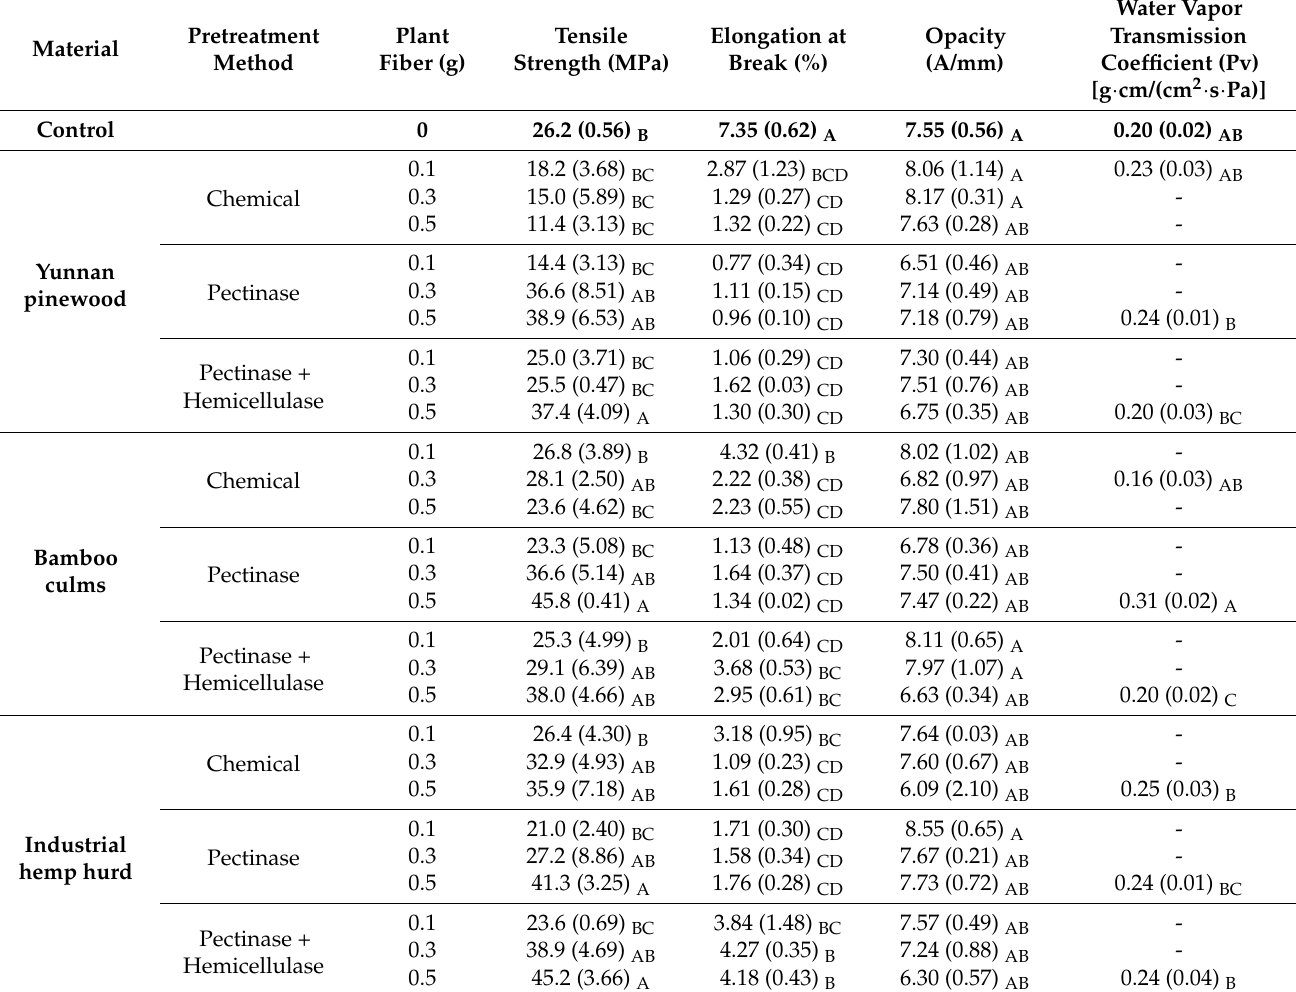
Table 5. Effect of addition of chemically or enzymatically derived Yunnan pine wood, bamboo culms, and industrial hemp hurd fibers to CMC film on the tensile strength, elongation at break, opacity, or vapor transmission a